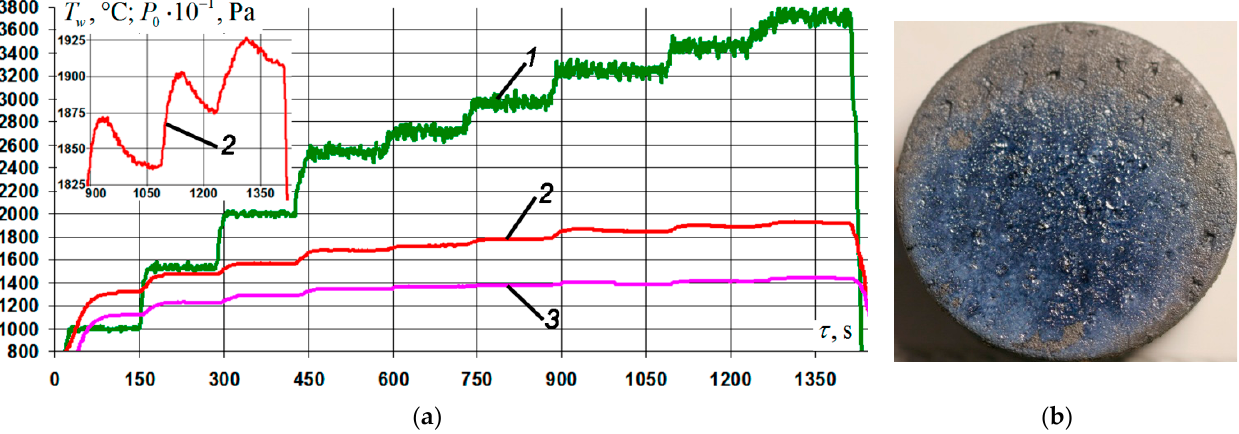
Figure 7. Results of gas-dynamic tests of C f /C–SiC samples coated with the Si–TiSi 2 –MoSi 2 –TiB 2 –CaSi 2 system at P 0 = 10–37.5 kPa: ( a ) change of mode parameters in time: 1—braking pressure in the pre-chamber of the heater, P 0 ; 2, 3—temperature of the front/back surface of the sample at the critical point, T w ; ( b ) typical view of the front side of the samples after testing.